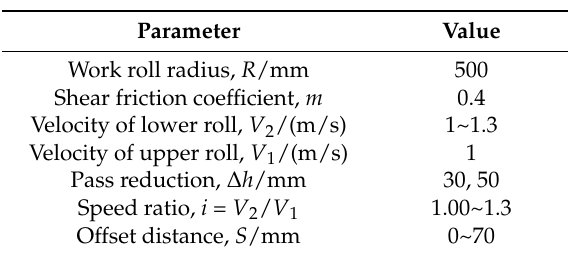
Table 1. Single rolling parameters.